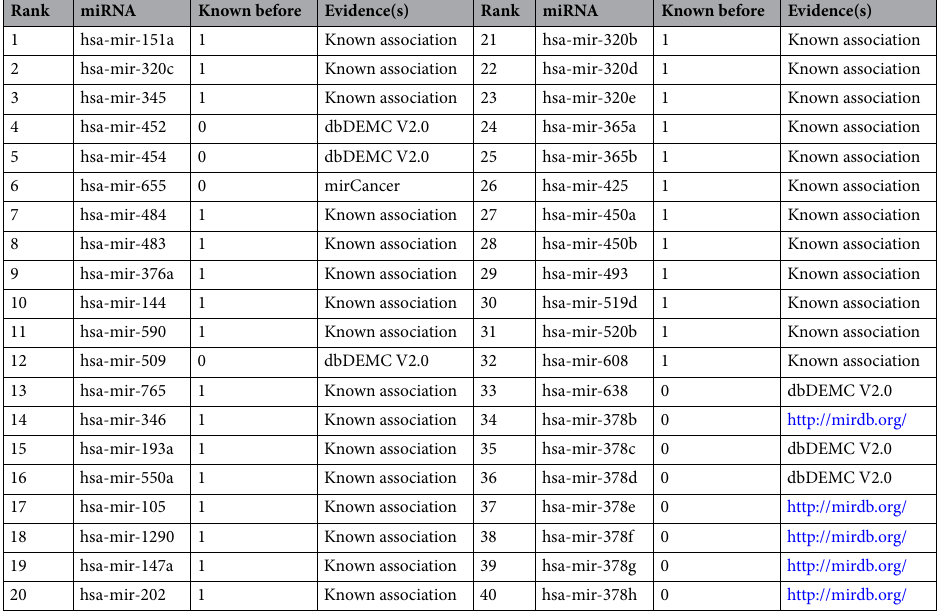
Table 4. Top 40 predicted hepatocellular carcinoma-associated